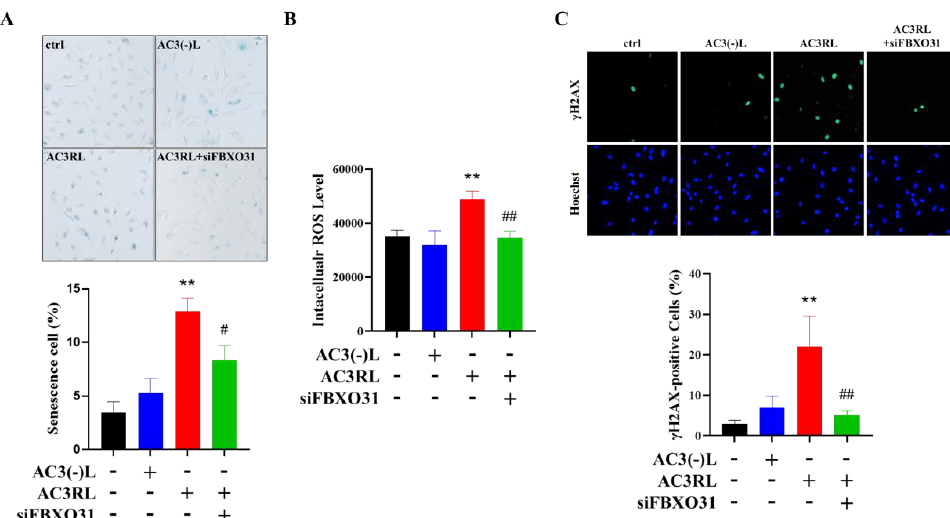
Figure 3. AC3RL induced cell senescence via FBXO31. HAECs were incubated with PBS (control, ctrl), AC3(-)L (25 µ g/mL), AC3RL (25 µ g/mL), and/or AC3RL + siFBXO31 (20 nM) for 24 h. ( A ) SA- β -Gal staining in HAECs from each treatment group. ( B ) Intracellular reactive oxygen species (ROS) production in HAECs. ( C ) Immunofluorescence staining showing γ H2AX foci in HAECs from each treatment group. Positively stained cells were quantified and are represented as a proportion of total cells. For the quantitative analyses, n = 3 per group. ** p < 0.01 vs. control; # p < 0.05, ## p < 0.01 vs. AC3RL.